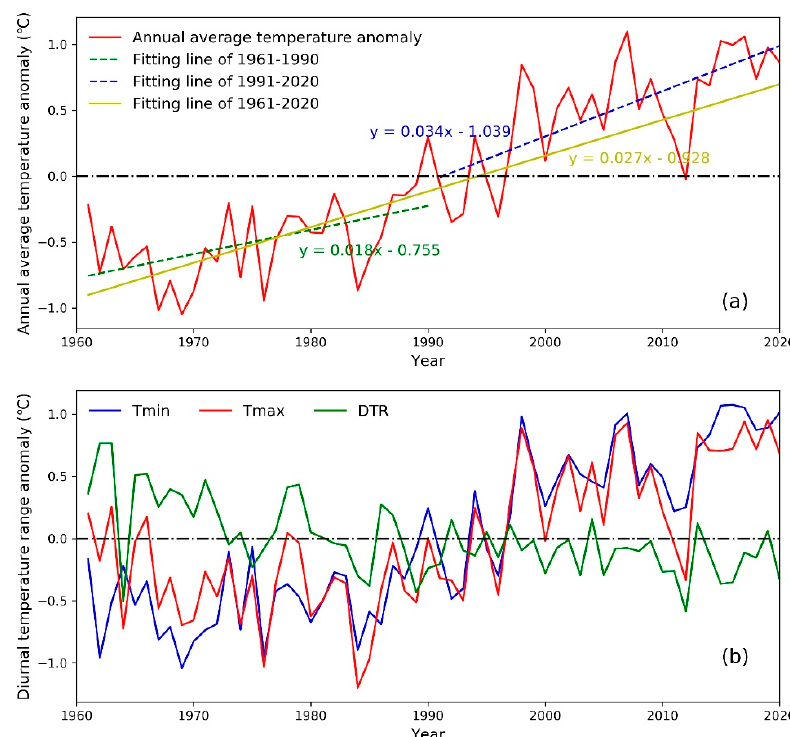
Figure 3. Annual average temperature anomaly ( a ) and diurnal temperature range anomaly ( b ) of China during 1961–2020. (Tmin: daily minimum temperature; Tmax: daily maximum temperature; DTR: diurnal temperature range).